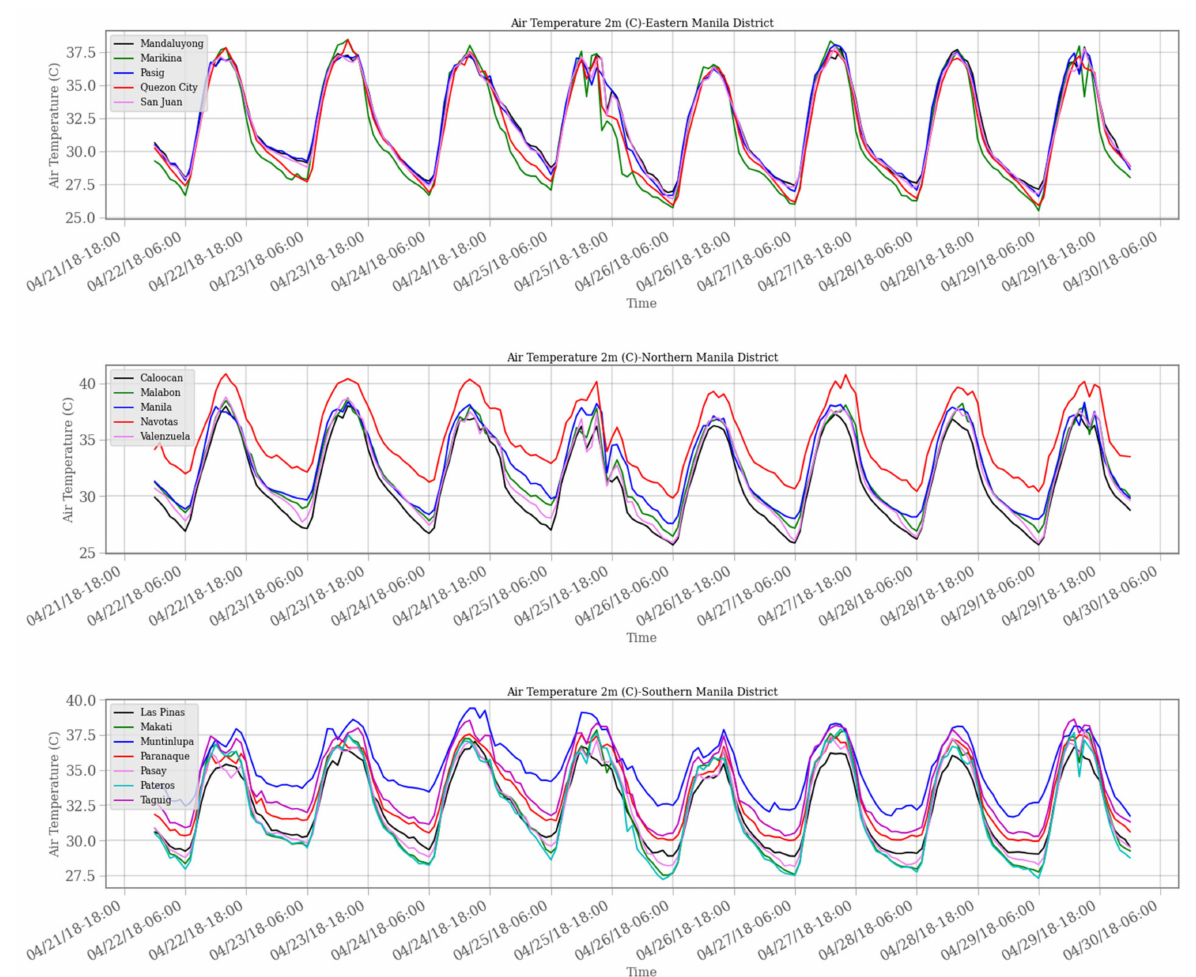
Figure 6. Temporal evolution of air temperature for the cities in the three administrative districts of Metro Manila. Eastern Manila District ( top ), Northern Manila District ( center ), and Southern Manila District ( bottom